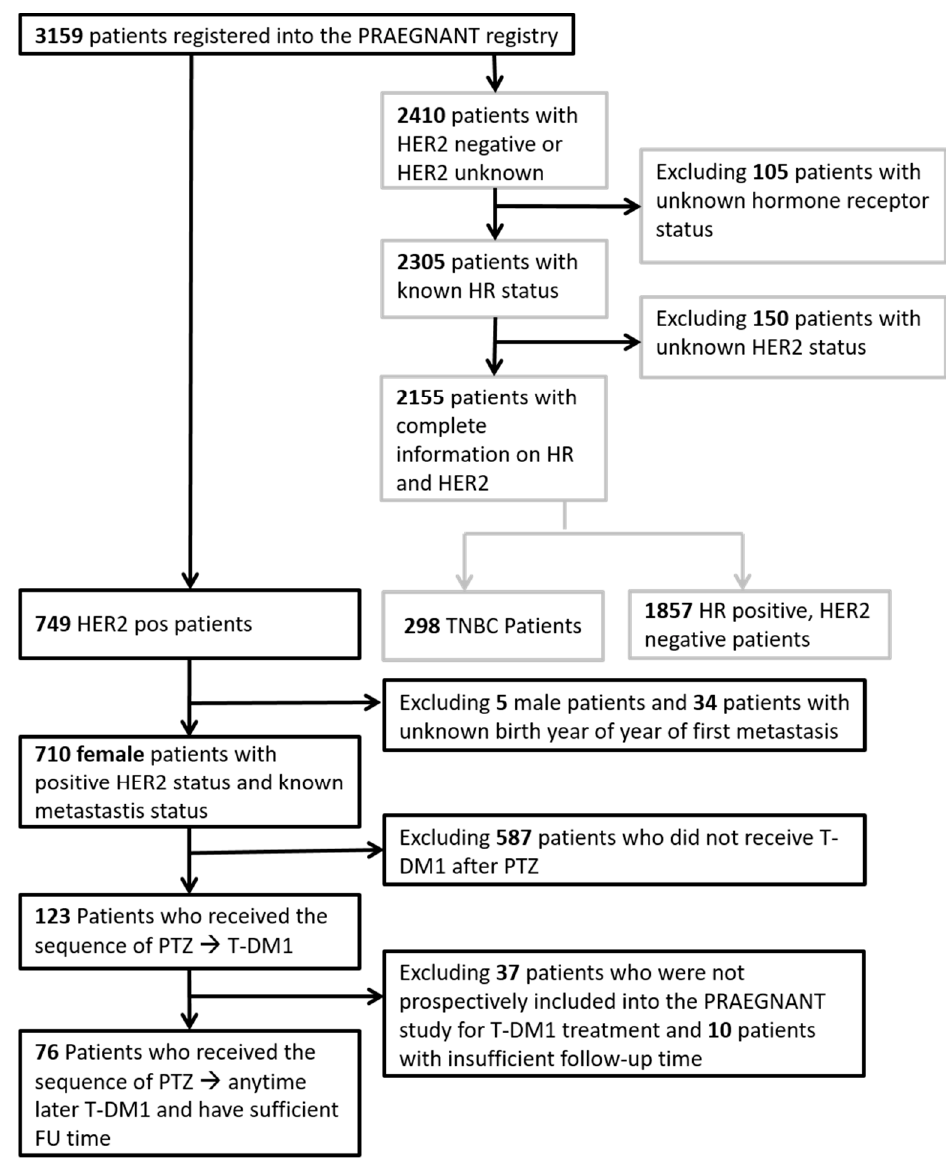
Figure 5. Flow chart. Black fields and arrows represent HER2 positive patient selection; grey fields and arrows represent HER2 negative or unknown patient selection; HER2: human epidermal growth factor receptor 2; HR: hormone receptor; pos: positive; TNBC: triple negative breast cancer; PTZ: pertuzumab; T-DM1: trastuzumab emtansine; FU time: follow-up time.